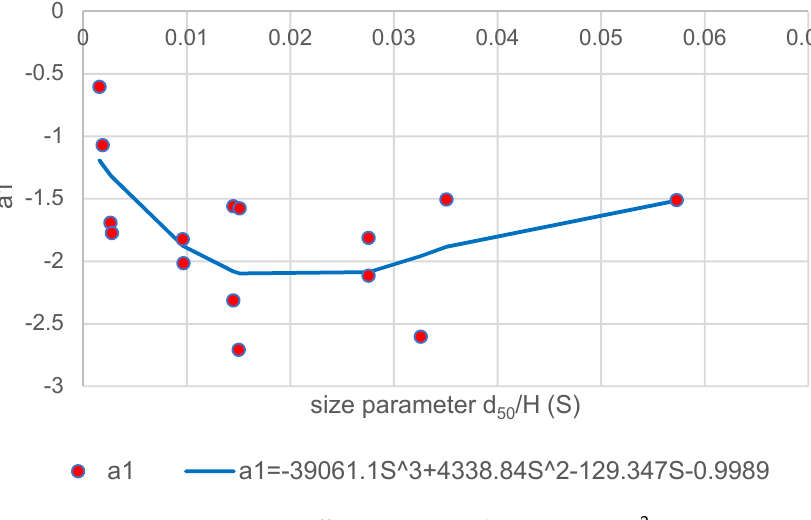
Figure 11. Size parameter vs. coefficient 𝑏 (cid:2870) using KNN ( 𝑅 (cid:2870) = 0.434 ). Figure 12. Size parameter vs. coefficient 𝑎 (cid:2870) using KNN ( 𝑅 (cid:2870) = 0.433 ).